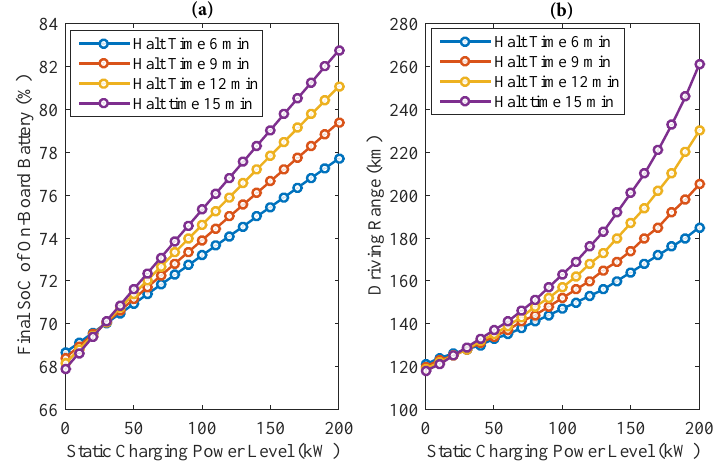
Figure 9. ( a ) On-board battery SoC ( b ) driving range versus static charging power level for different starting and halt